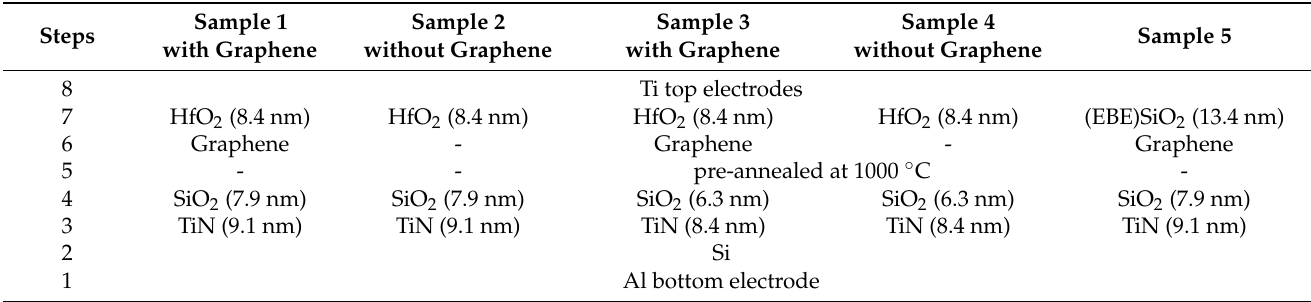
Table 1. Schematics of the nanostructured stacks expressed in separate columns, denoted by Samples 1–5. All stacks were mounted between ohmic Al electrode contacts on the bottom and Ti electrodes on the top. The rest of the constituent material’s layers, if present, are denoted by the corresponding chemical formulae. The temperature of the annealing procedure is denoted. The thicknesses of films, evaluated by X-ray reflectometry, are revealed by each material layer. The thickness measurement uncertainty is ±0.5 nm.